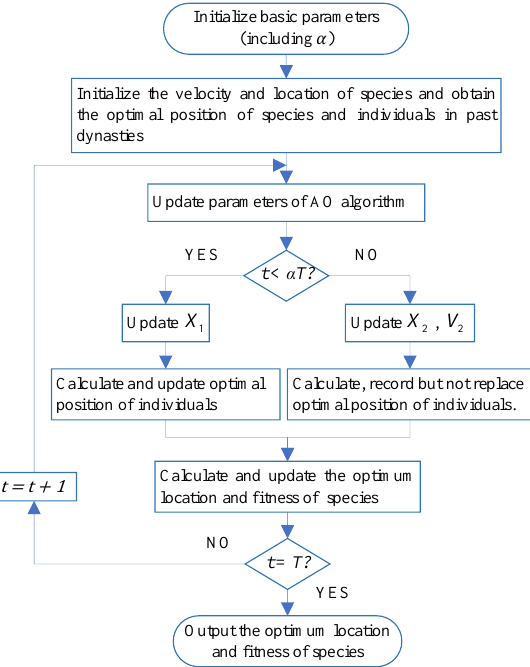
Figure 3. The flow chart of particle swarm aquila optimization.